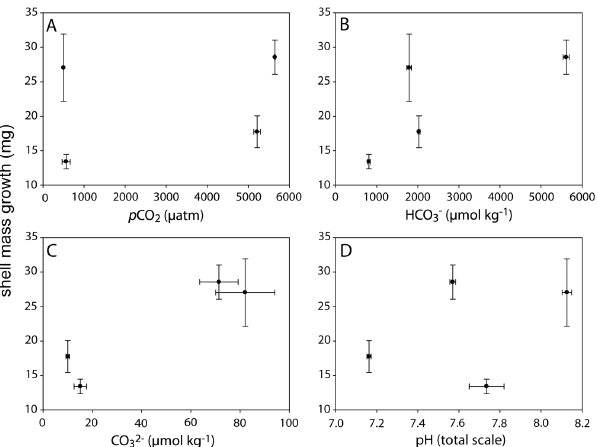
] and [HCO − ] / [H + ], signif- 3 3